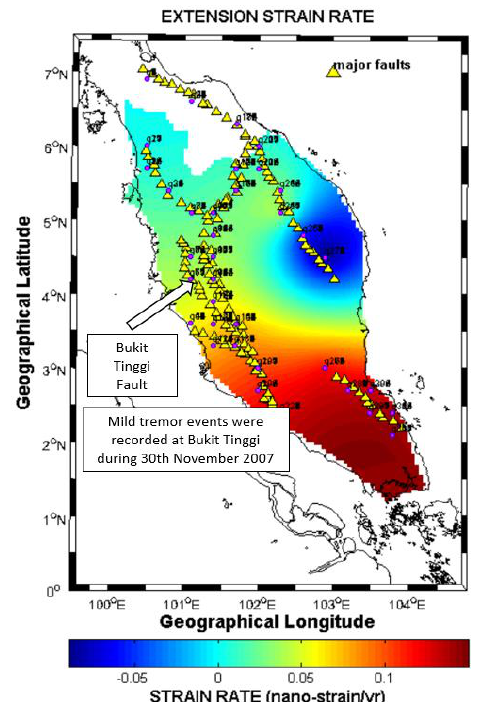
Figure 16. Strain rate (Extension) map contour over Peninsular Malaysia (2004-2013).